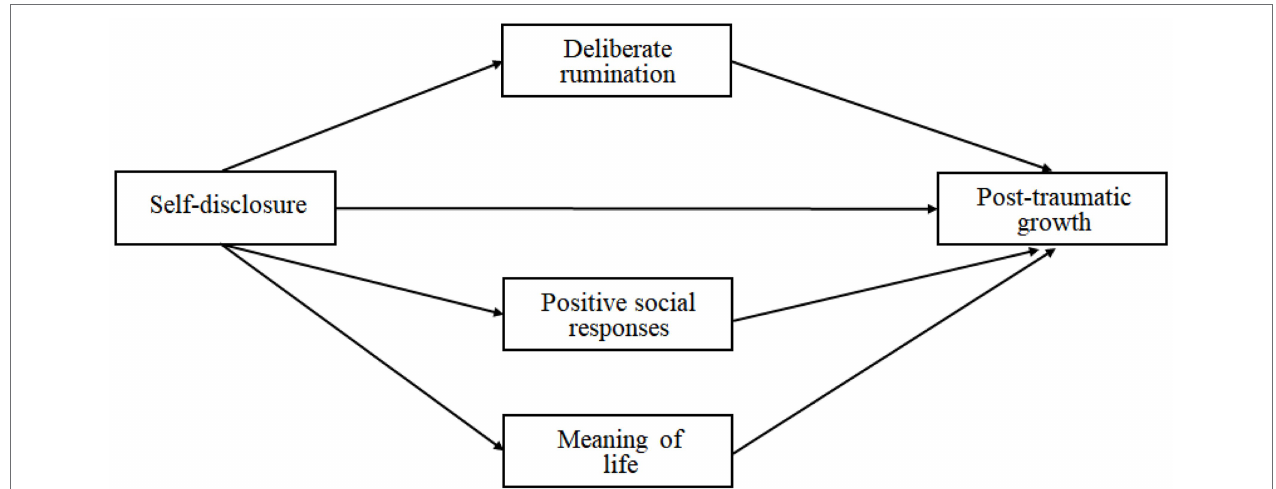
FIGURE 1 | Proposed multiple mediating